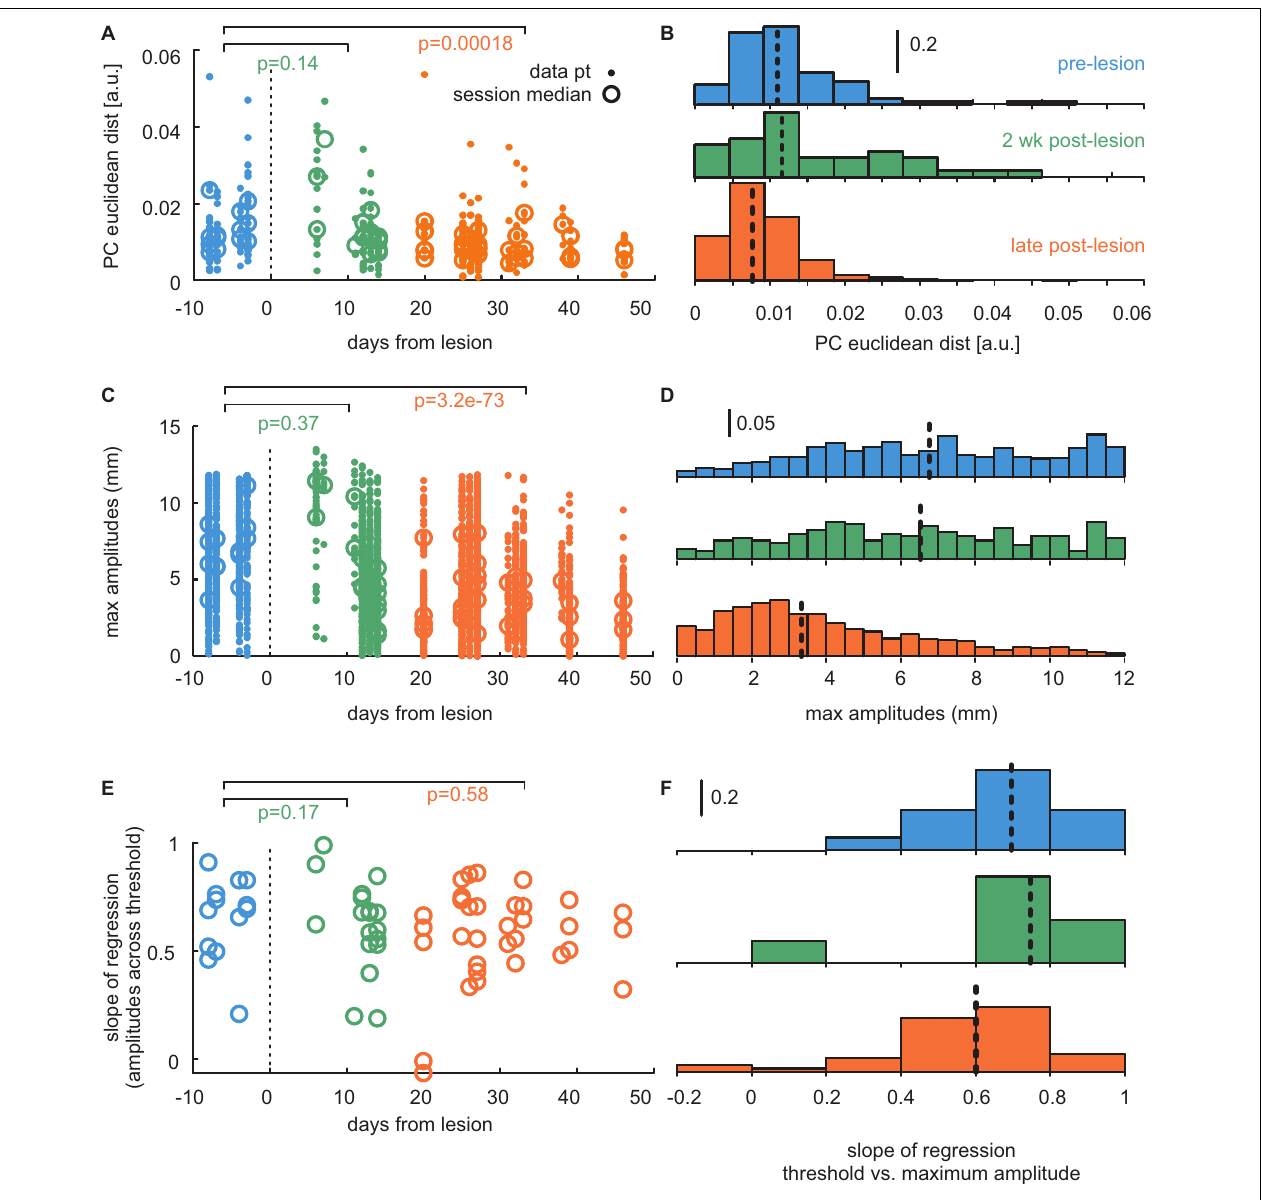
FIGURE 6 | Population data from three mice. (A) Distance of center of mass (PC1 vs. PC2) between whisker trajectories generated with different thresholds. The p -values are denoted. Dots: single sessions. Circles: session means. Blue: pre-lesion data. Green: Data obtained up to 12 days post-lesion. Orange: Post-lesion data obtained later than 12 days after lesion. (B) Same data as the dots in panel (A) , now depicted as a histogram. Colors match. Broken lines: sample median. (C) Maximum positions of whisks. Conventions as in panel (A) . (D) Same data as in panel (C) . Conventions as in panel (B) . (E) Adaptation expressed as the slope of regression line obtained with threshold and maximum position (cf. panels C in Figures 2, 4, 5 ). Conventions as in panels (A,C) . (F) Same data as in panel (E) . Conventions as in panels (B,D)